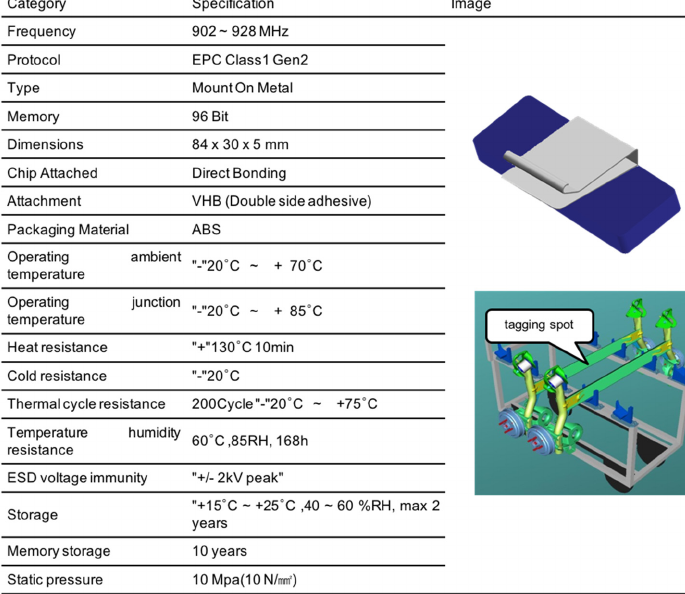
Figure 5. Production monitoring in the supplier plant. ( a ) Read point at production line; ( b ) Read point at 7 ‐ rack loading area; ( c ) Screen shot of production monitoring application.